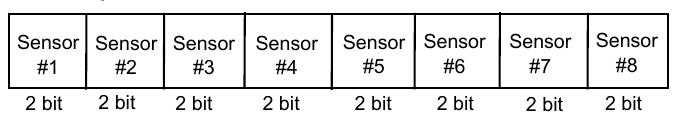
Figure 3. Fusing sensors’